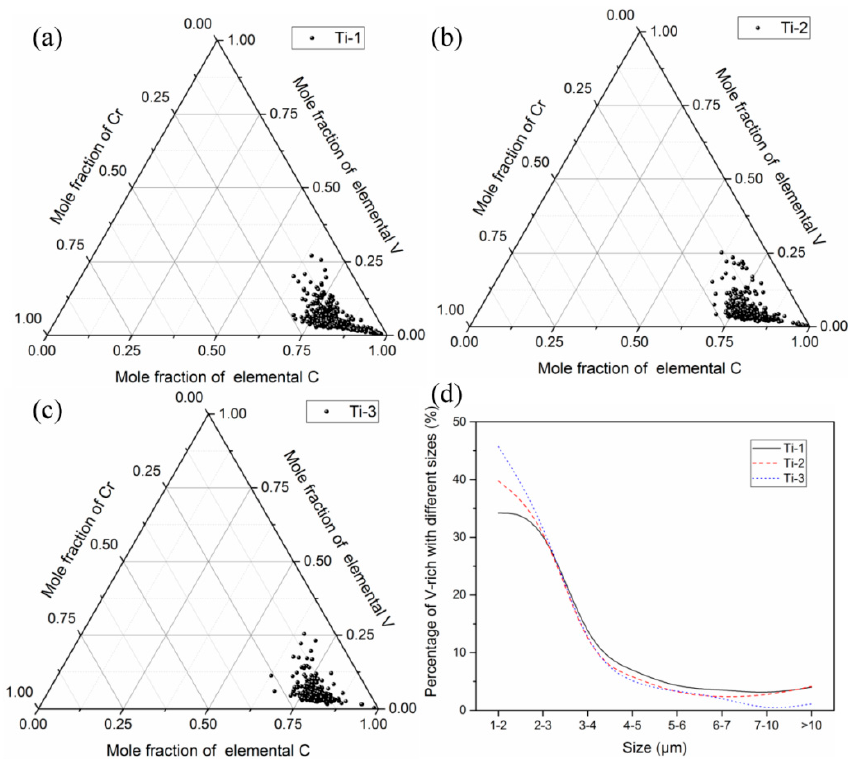
Figure 8. Composition ( a–c ) and size ( d ) of V-rich carbide inclusions in the